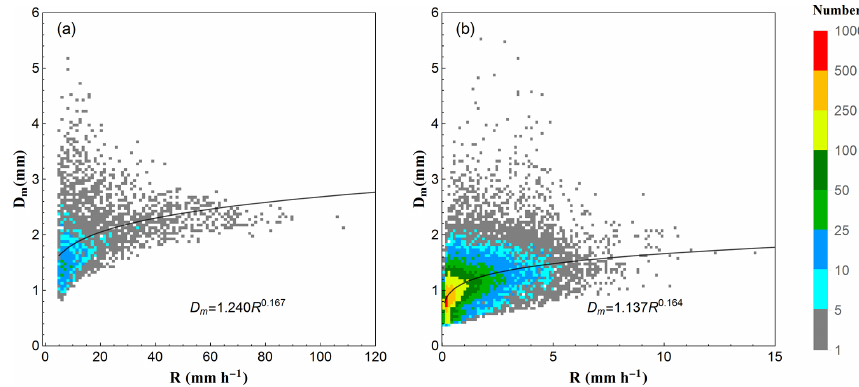
Figure 4. Scatter density plot for D m (mm) versus R (mmh − 1 ) for (a) convective events and (b) stratiform events. The fitted power-law relationships are also provided in each panel adopting a least-squares